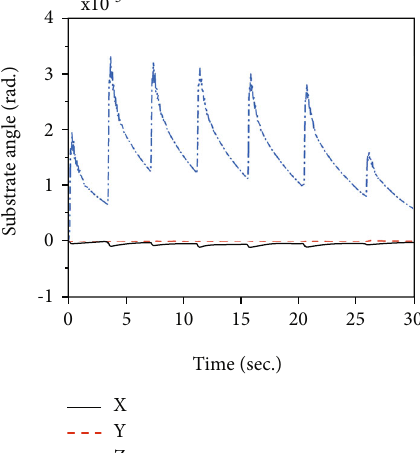
Figure 3: Joint angle error.